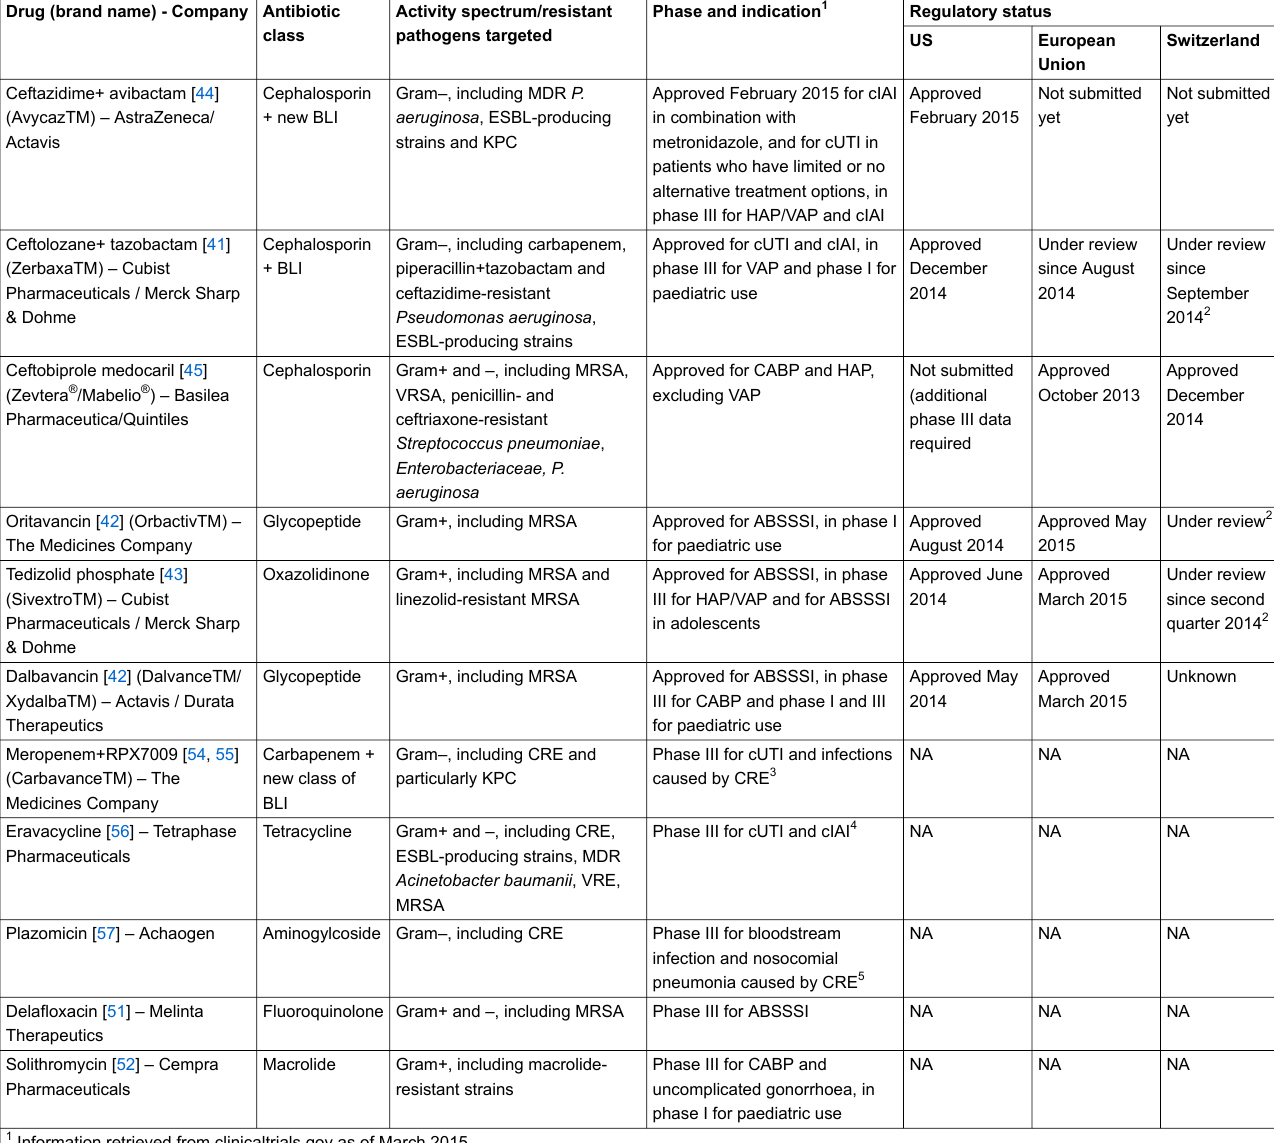
Table 2: Late-stage pipeline: systemic antibiotics recently approved, in registration or in phase III of clinical